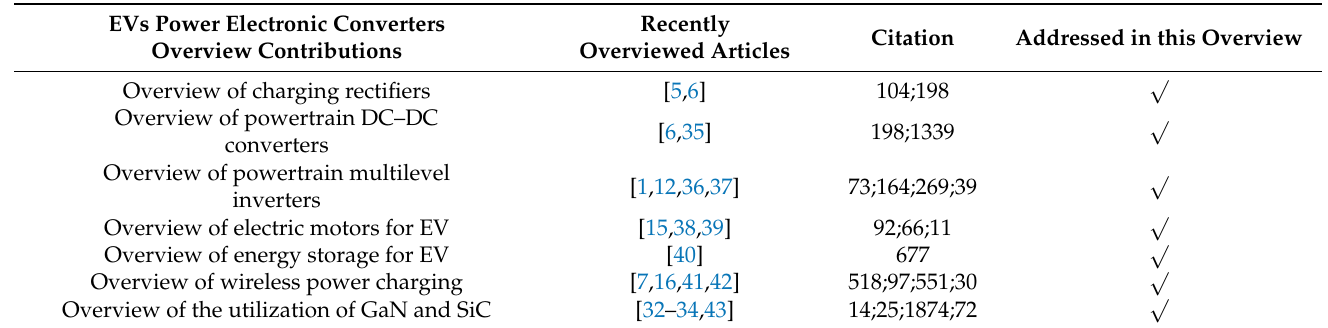
Table 1. Recent overviewed literature on power electronic converters, electric motors, and energy storage for electric vehicle